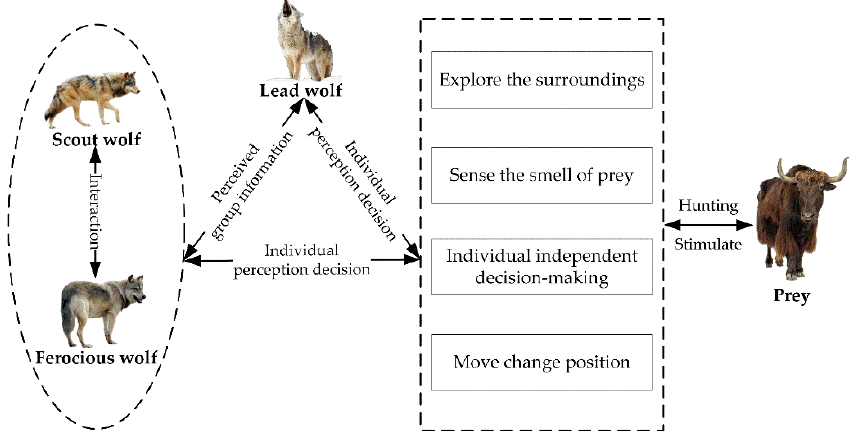
Figure 4. Basic principle model of the WPA.